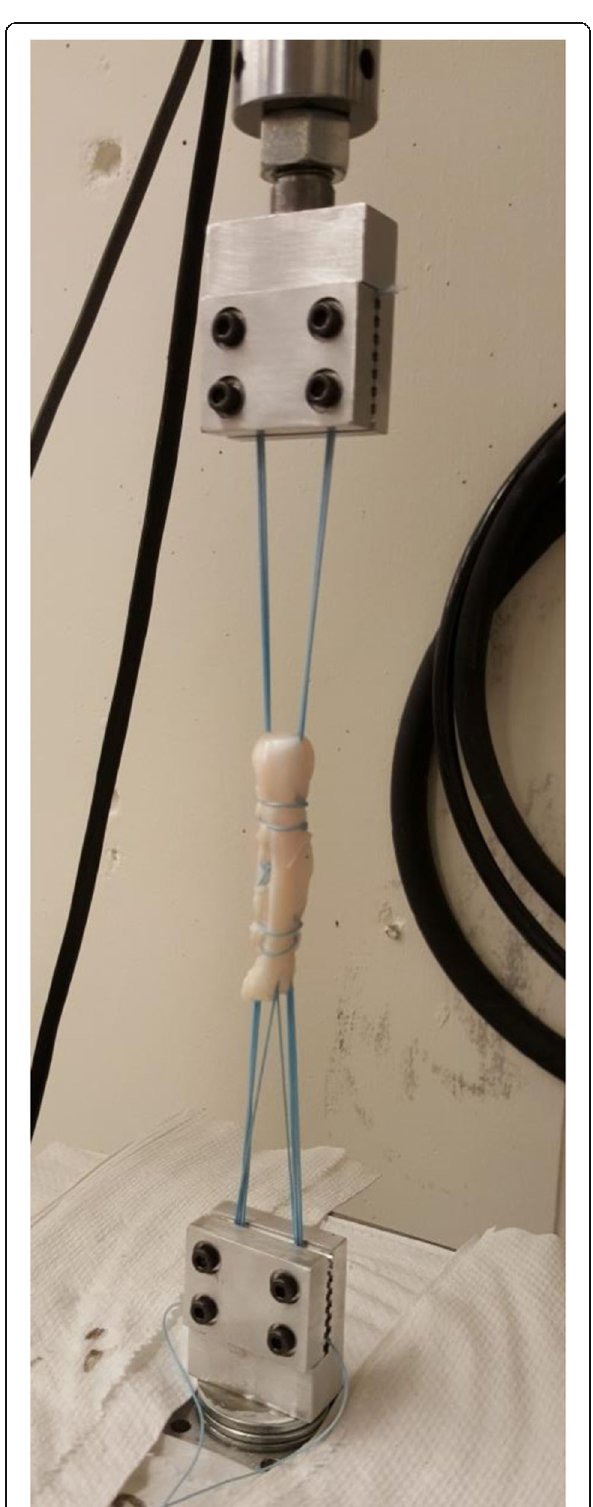
Fig. 2 A quadrupled tendon suspended using No. 5 suture from clamps in the MTS